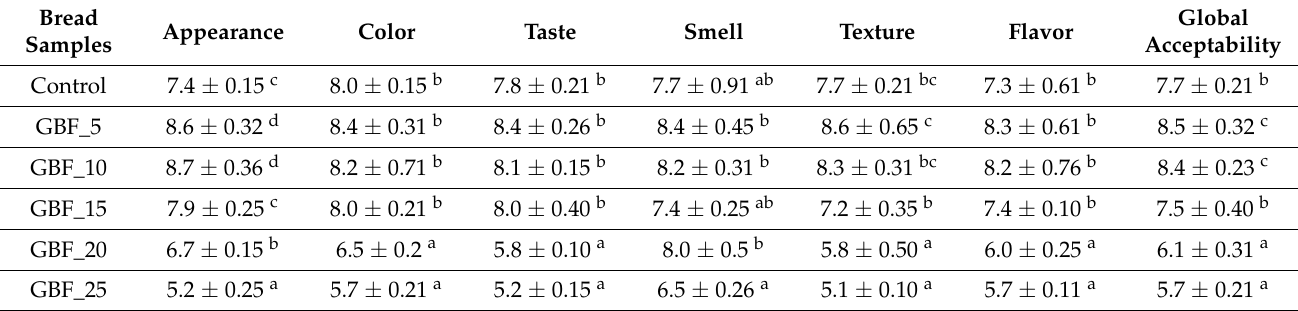
Table 7. Sensory analysis of the bread samples with different levels of germinated bean flour (GBF) additions. Bread Appearance Color Samples